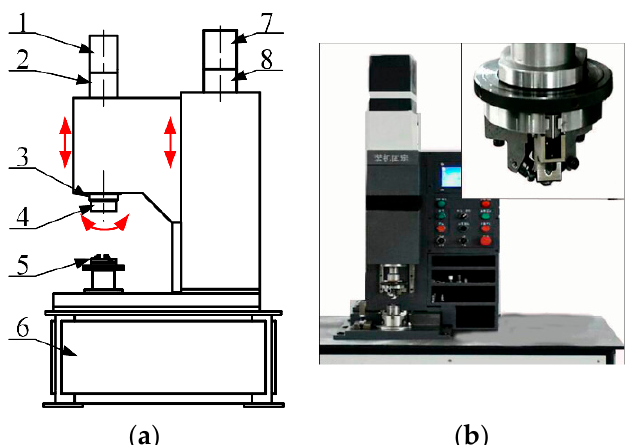
Figure 11. Schematic diagram of the roller swaging apparatus and the structure of the roller tool: ( a ) Schematic diagram of the roller swaging apparatus; ( b ) Real test machine. 1—Electric cylinder; 2—Pressure transducer; 3—Machine tool fixture; 4—Roller tool; 5—Fixed fixture; 6—Frame; 7—Drive motor; 8—Reducer.